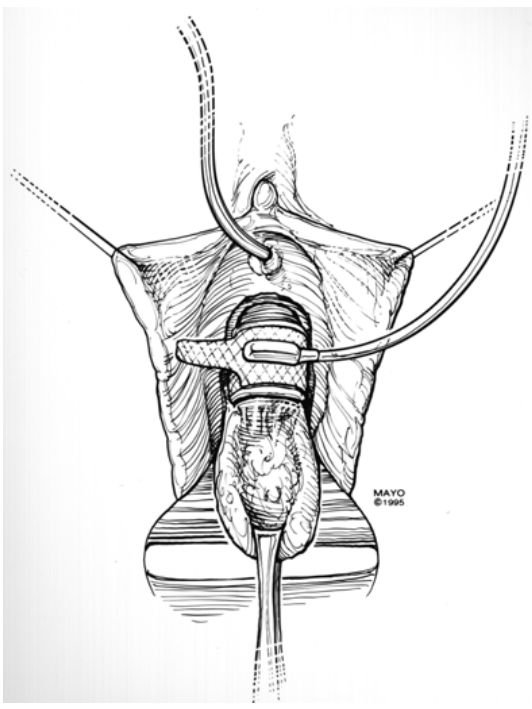
FIGURE 14. Completed cuff